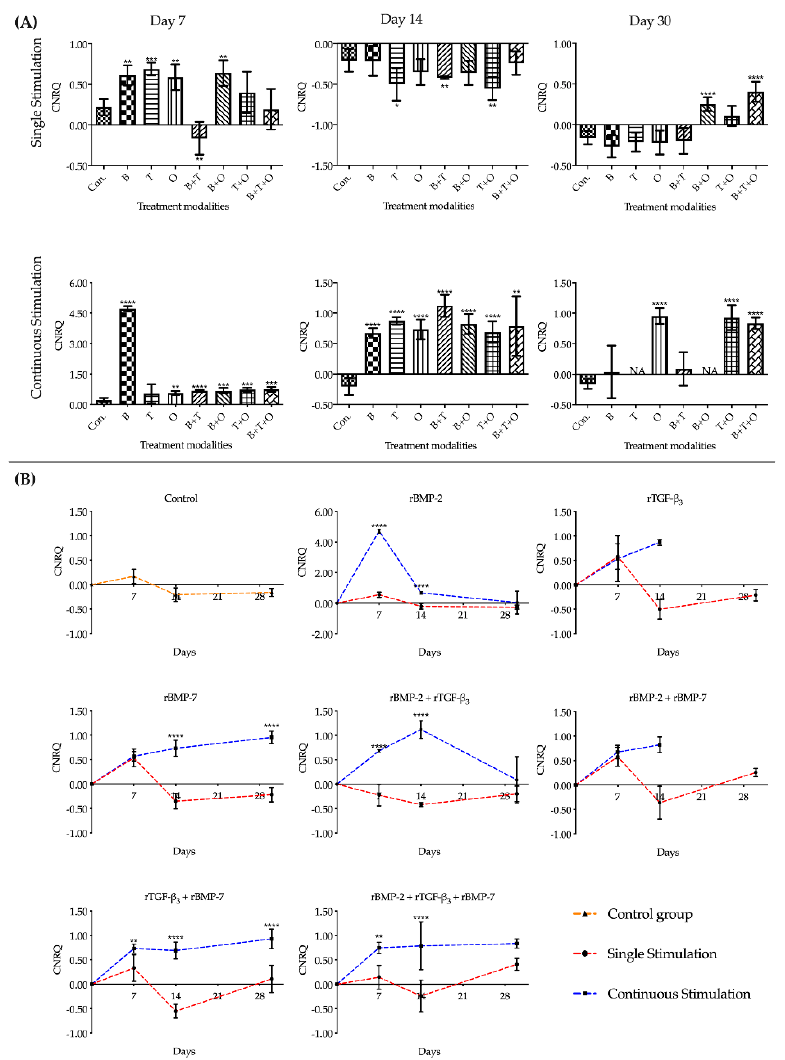
Figure 3. The analyses of the relative gene expression levels of collagen type II alpha 1 ( Col2 α 1 ). The results were presented as calibrated normalized relative quantity (CNRQ). ( A ) Comparisons between each experimental group under di ff erent stimulation modes and the corresponding control group at day 7, 14 and 30 using one-way ANOVA. ( B ) Comparisons between the experimental groups where growth factors were applied continuously and the corresponding 48 h withdrawal groups at day 7, 14 and 30 using two-way ANOVA. The data volume in the experimental groups applied rTGF- β 3 and rBMP-2 + rBMP-7 continuously at day 30 could not meet the requirements of the statistical analysis. NA = not available. Con. = control group, B = rBMP-2 treated group, T = rTGF- β 3 treated group, O = rBMP-7 treated group, B + T = rBMP-2 + rTGF- β 3 treated group, B + O = rBMP-2 + rBMP-7 treated group, T + O = rTGF- β 3 + rBMP-7 treated group, B + T + O = rBMP-2 + rTGF- β 3 + rBMP-7 treated group. Number of replicates ( n ) = 6. We defined p < 0.05 as a statistically significant di ff erence. * p < 0.05, ** p < 0.01, *** p < 0.001, **** p < 0.0001. In ( A ) statistical significance is expressed between each group and the control group (normal medium), while in ( B ) it is expressed in each time point between continuous stimulation and single stimulation. The baseline 0 represents fresh non-cultured muscle tissue which was the normalization